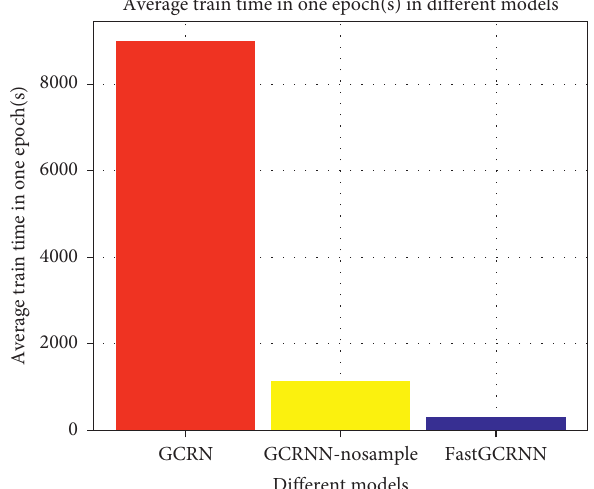
Figure 7: Time consumption of training an epoch with different models.